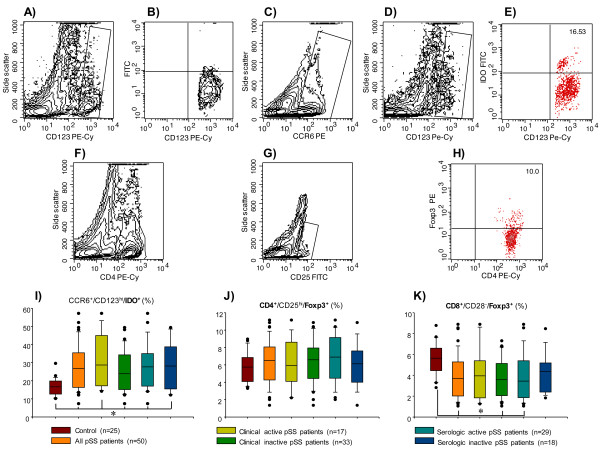
Percentage of indoleamine 2,3-dioxygenase (IDO)- and Foxp3-expressing peripheral blood cells in patients with primary Sjögren's syndrome (pSS). (A,B) Control of fluorescein isothiocyanate (FITC)-labeled-rabbit anti-sheep specificity staining. (C) An electronic gate was made for CCR6+ cells. (D) From the gate C CCR6+⁄CD123hi cells were determined. (E) From the latter CCR6+⁄CD123hi⁄IDO+ cells were defined. (F) An electronic gate was made for CD4+ cells. (G) From the gate F CD4+⁄CD25hi were determined and an electronic gate was made for double positive cells. (H) From the latter CD4+⁄CD25hi⁄Foxp3+ cells were defined. Bar graphs show percentage of (I) CCR6+⁄CD123hi⁄IDO+ cells, (J) CD4+⁄CD25hi⁄Foxp3+ cells, (K) CD8+⁄CD28-⁄Foxp3+ cells. A total of 100,000 to 250,000 events were recorded for each sample before any gate setting, and were analyzed with the CellQuestPro software (BD Biosciences). (I-K) Results are expressed as median, 10th, 25th, 75th, and 90th percentiles. *P < 0.05.